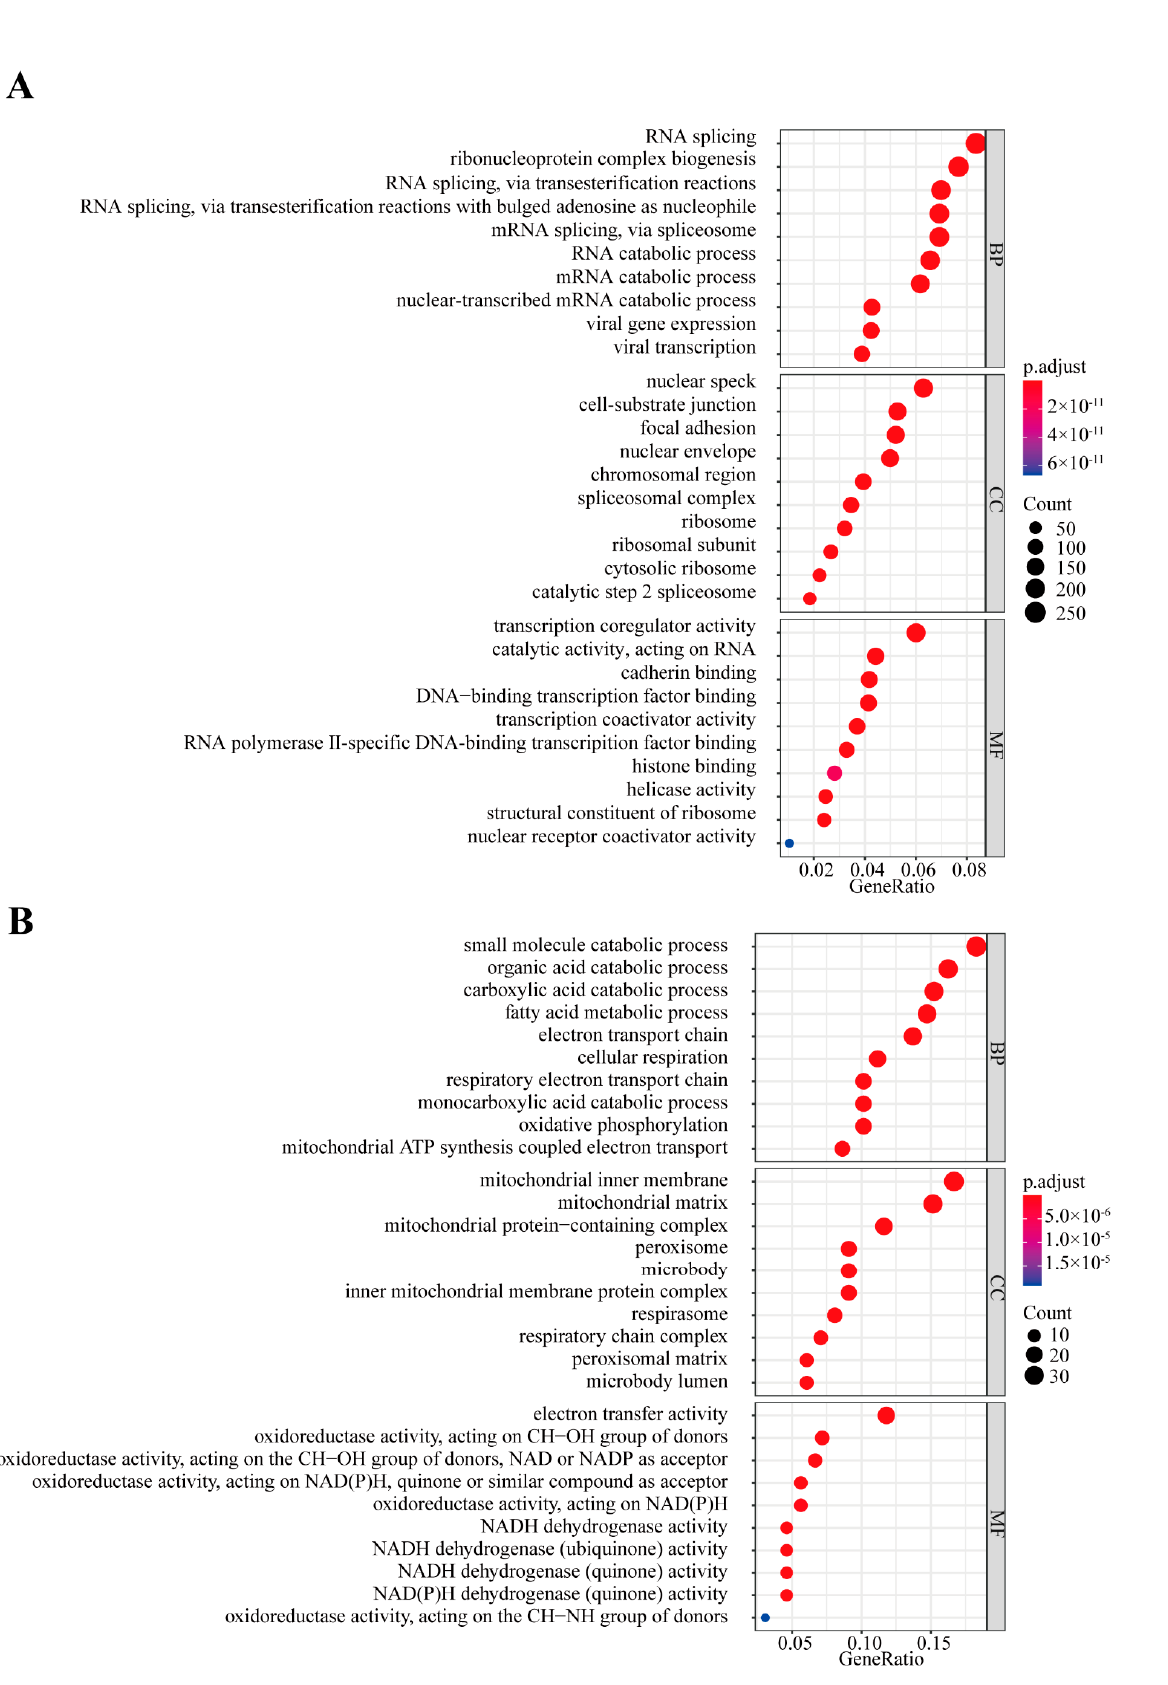
Figure 3. Functional annotation and lncRNA-mRNA interaction network. ( A ) GO annotation of mRNAs that were positively correlated with U1-lncRNAs. ( B ) GO annotation of mRNAs that were negatively correlated with U1-lncRNAs.